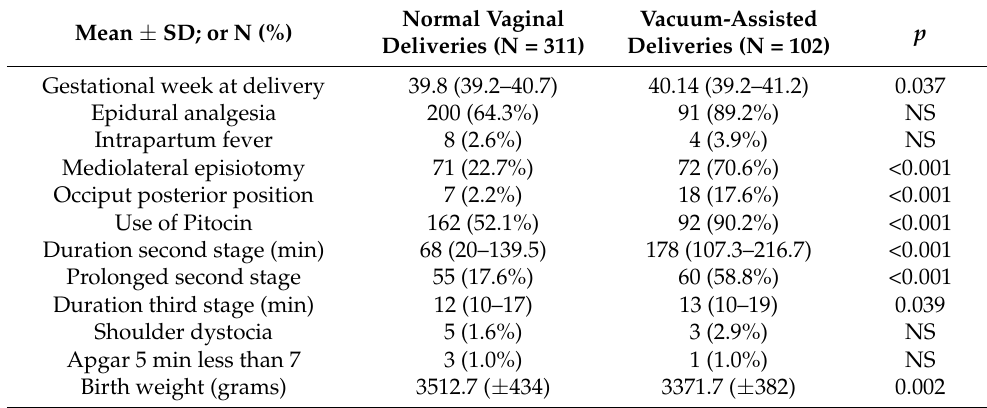
Table 3. Comparison of intrapartum obstetric parameters of women with OASIS according to the mode of